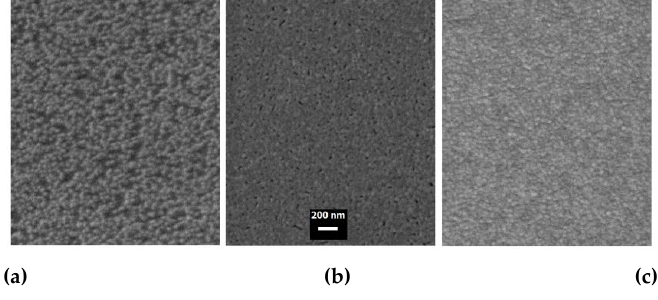
Figure 1. SEM images GAG-0 ( a ), GA ( b ), and GAG-3 samples ( c ).